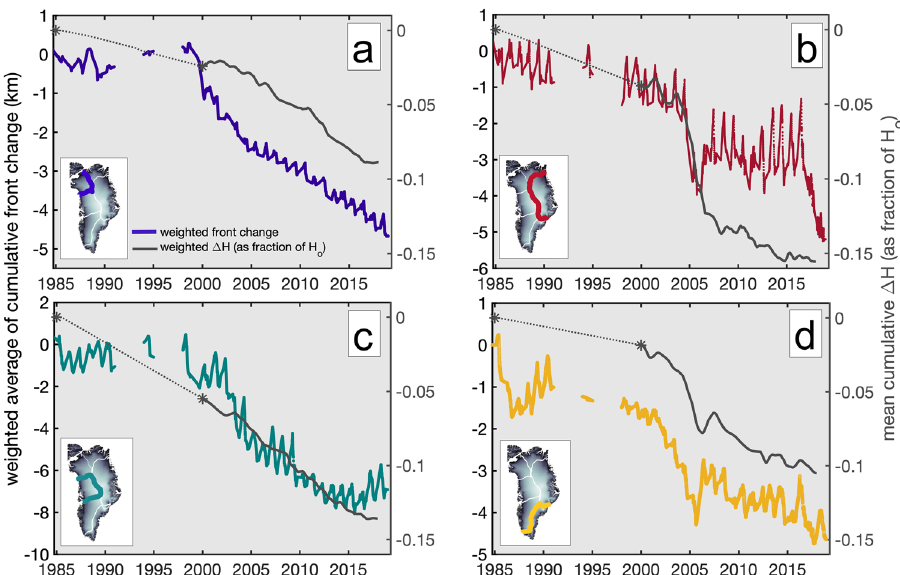
Fig. 3 Mean regional trends in ice thickness and front position. Net regional trends in (black curves) ice thickness and (colored curves) front position, calculated from discharge-weighted individual glacier time series in the northwest ( a ), central east ( b ), central west ( c ), and southeast ( d ), with the colors corresponding to the locations mapped in the left plane. Negative values on the left y -axis indicate net cumulative retreat over the study period. Cumulative thickness changes are shown on the right y -axes, and are calculated from the mean of all regional glaciers and expressed as fractional changes from H o . Lighter, dotted gray lines between the two starred points indicate linear interpolation between two sparse data points, and the apparent trend during this period should be treated with caution. Please note that the limits along the left y -axes vary between panels so that time series details are more